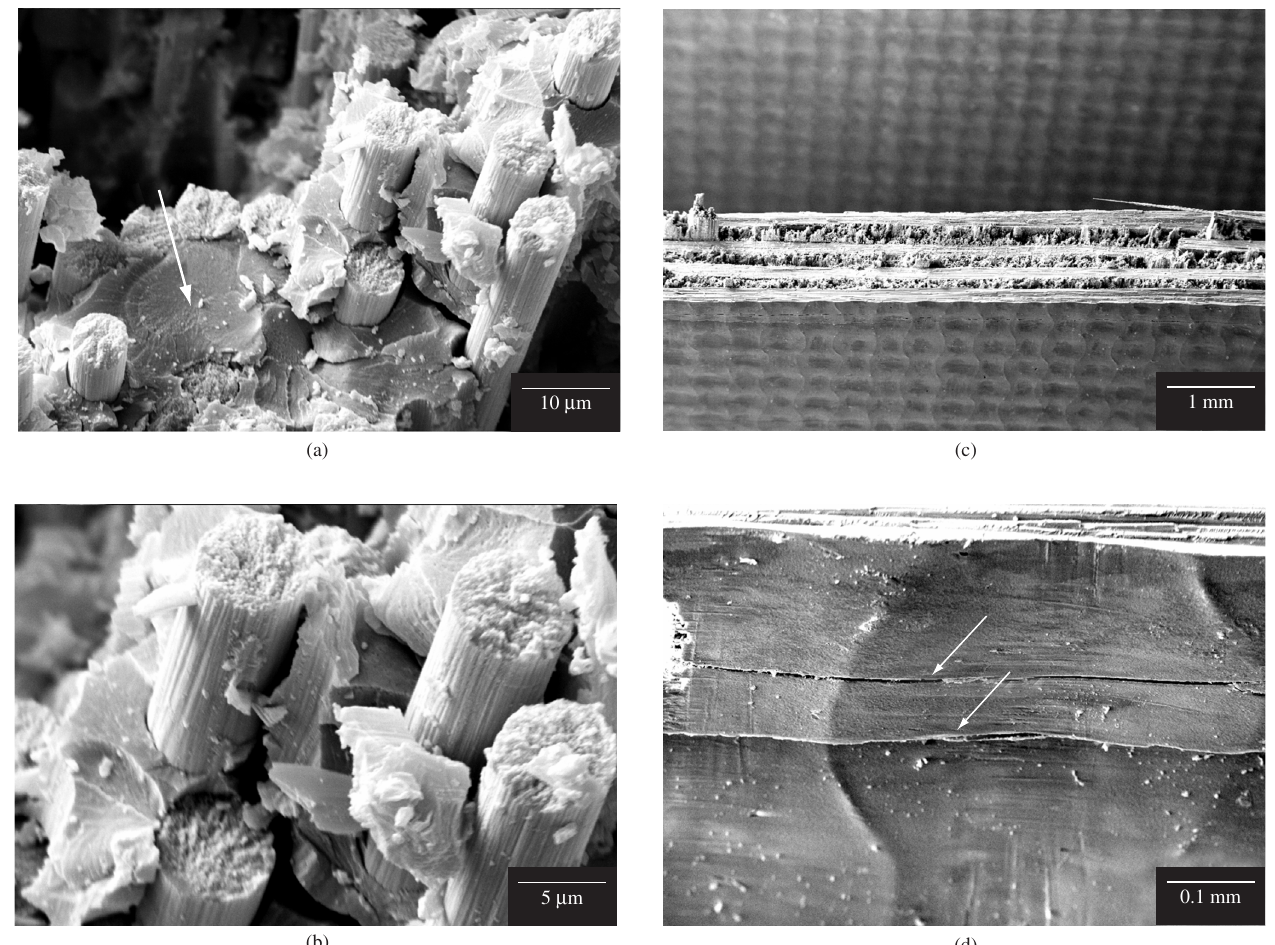
Figure 9. Micro-fractographs of carbon-epoxy laminates tensile tested following prior fatigue loading: a,b) Increased ultimate strength of tape cured at 120 °C and 420 kPa (60 psi); and c,d) Cyclic tenacification of tape cured at 180 °C and 700 kPa (100